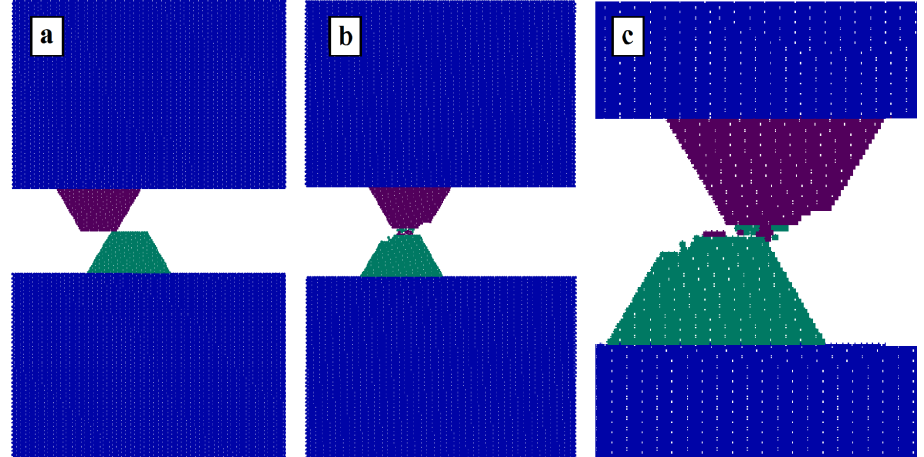
Fig. 3. “Grinding” regime of asperities